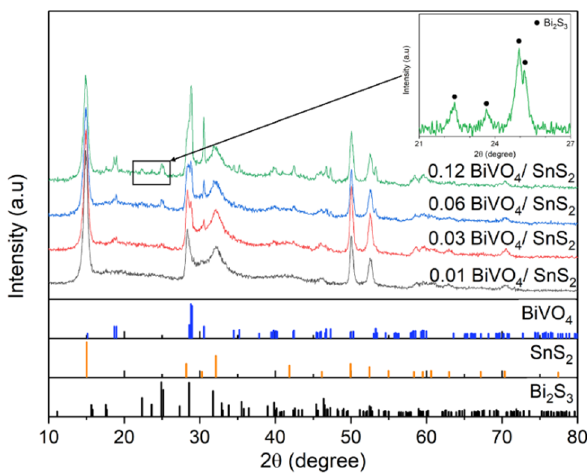
Figure 1. XRD pattern of BiVO 4 /SnS 2 samples with various ratios of BiVO 4 and SnS 2 .